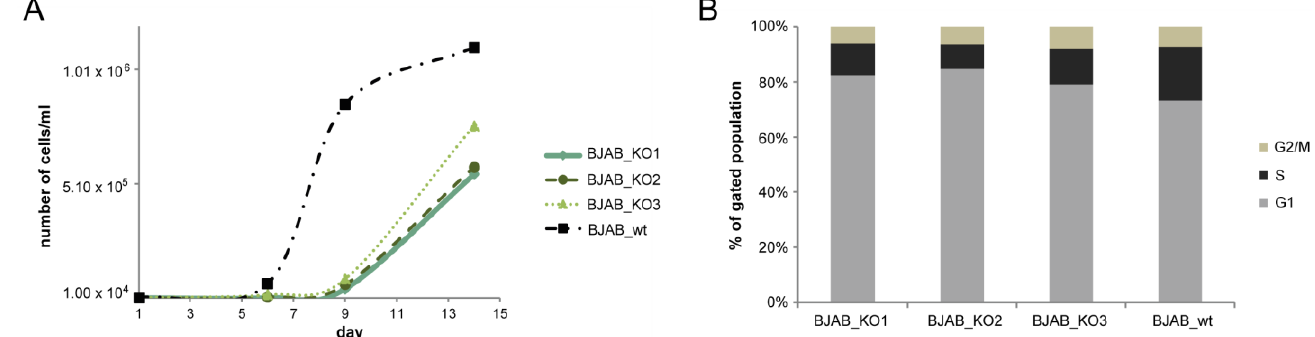
Figure 2. Growth properties of BJAB-miR-142 knockout clones. The BJAB wild-type (“wt”) and three knockout clones were seeded at 10.000 cells/mL and counted at the indicated days post-seeding ( A ). A cell cycle analysis of the BJAB wild-type cells and three knockout clones is shown in panel ( B ). The cells were stained with propidium iodide and analysed with a BD FACSLyric flow-cytometer.